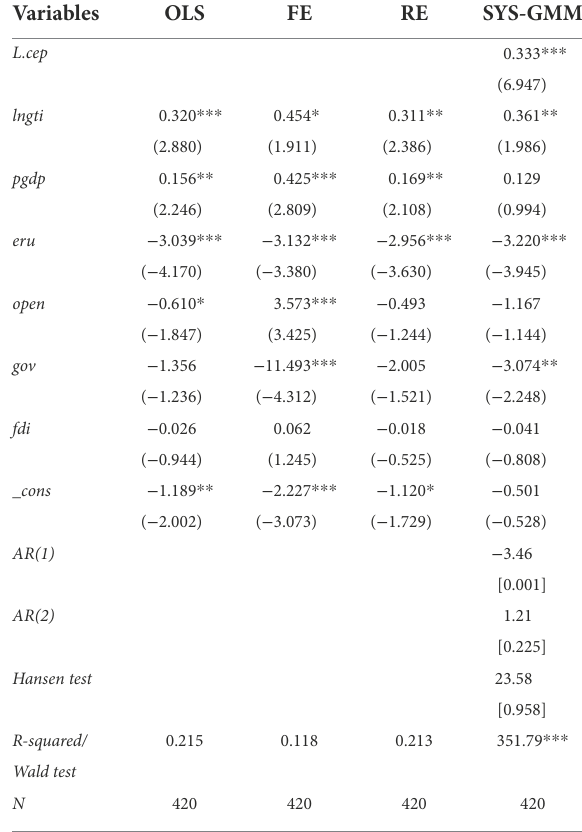
TABLE 2 The regression results of green technology innovation on carbon emission